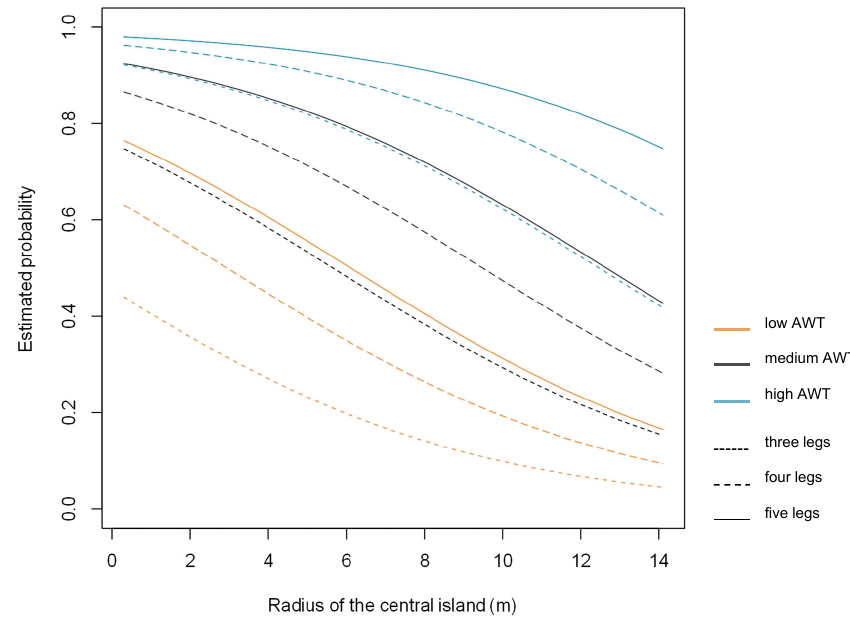
Figure 3. Accident occurrence probability vs. radius of the central island: Estimated probabilities of having had at least one accident recorded at a roundabout with low (3048, midpoint first quartile) [orange], median (10,903) [black] and high (24,239, midpoint last quartile) [blue] average weekday motorized traffic against the radius of the central island for roundabouts located in town with three [dotted line style], four [dashed] and five [continuous line style] entering